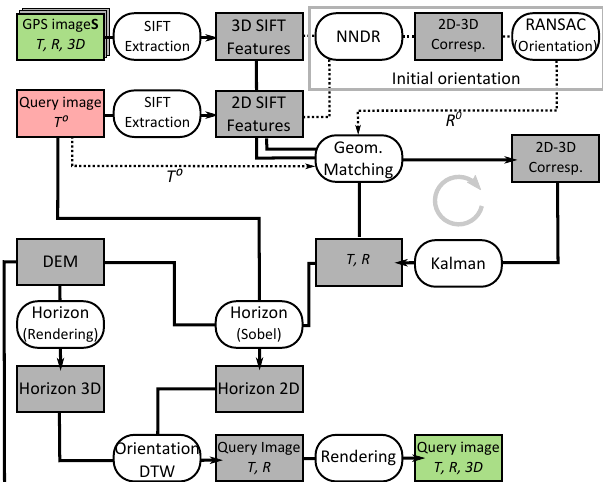
Figure 3: Processing of the query images, T 0 refers to the geotag, R is the orientation of the camera.